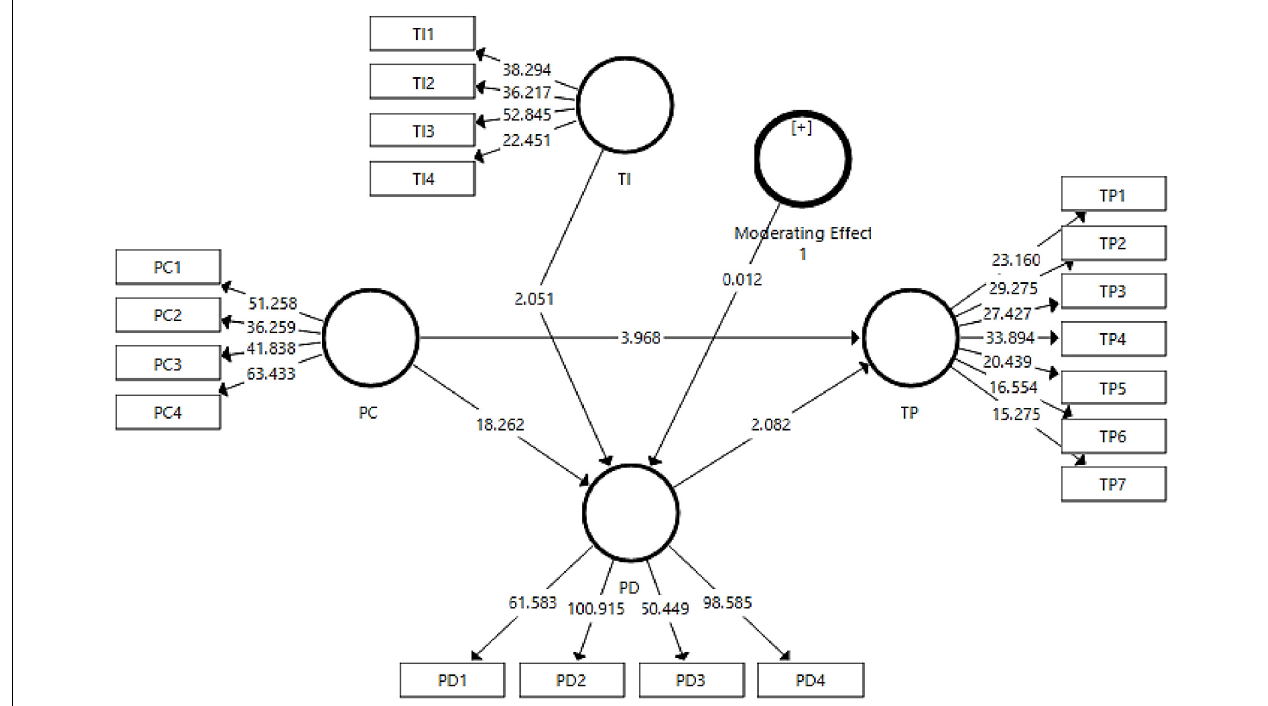
FIGURE 4 | Output of structural model (with